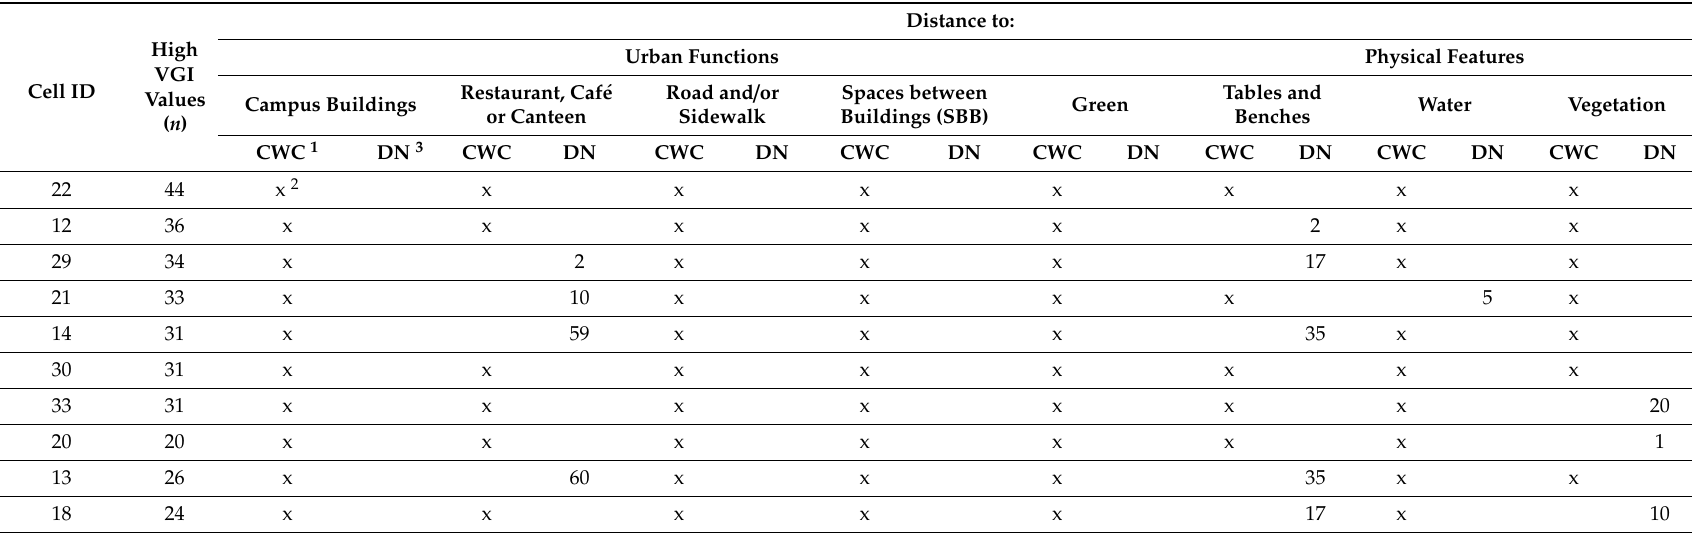
Table 7. Distances between VGI data and built-environment features at